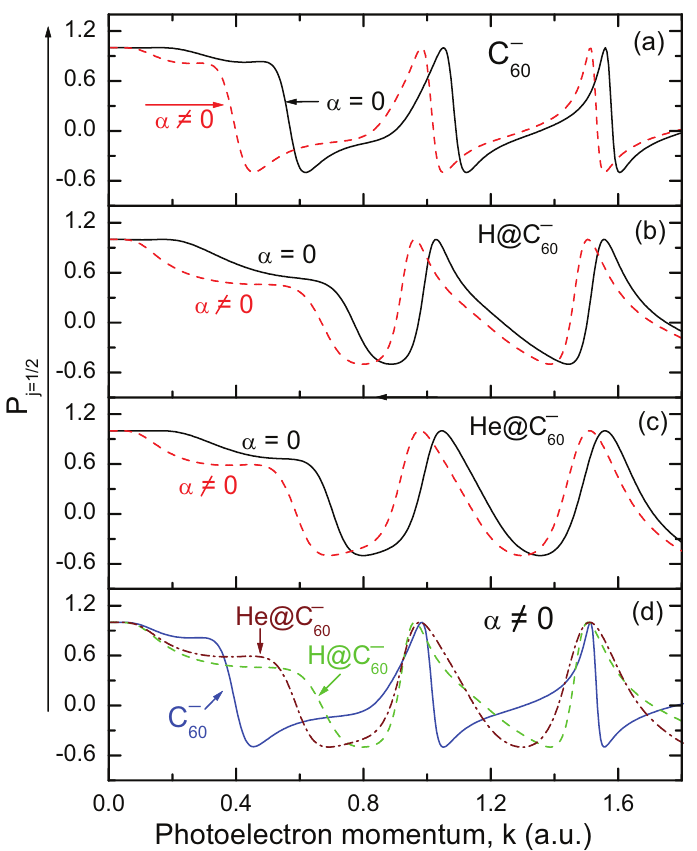
Figure 3. The angle-integrated degree of photoelectron spin polarization, P of the fullerene anions calculated without account ( α = 0) and with account ( α (cid:54) = 0) for polarization of the C 60 cage by the outgoing photoelectron, as marked. ( a ) P ( 2 p ) . ( d ) Calculated P ( c ) P for He@C − j = 1 2 60 the same plot to ease the comparison between